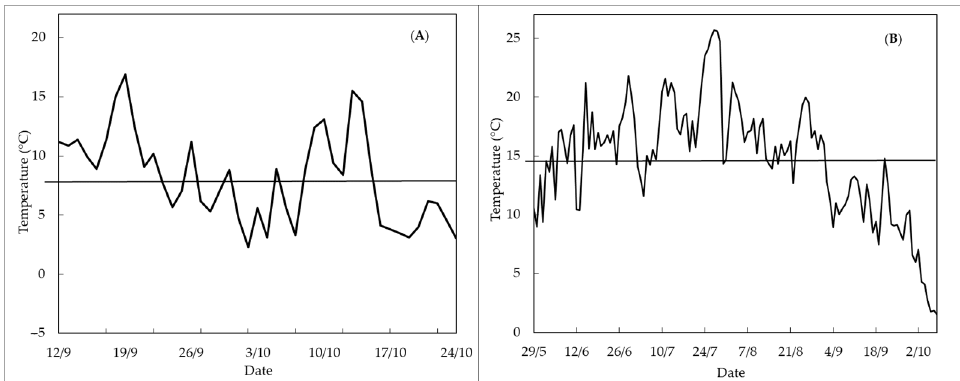
Figure 1. Daily mean temperatures during the outdoor period of plant raising in 2018 ( A ), and in the plastic tunnel during the cropping season in 2019 ( B ). The horizontal lines represent the average daily mean for the respective periods.